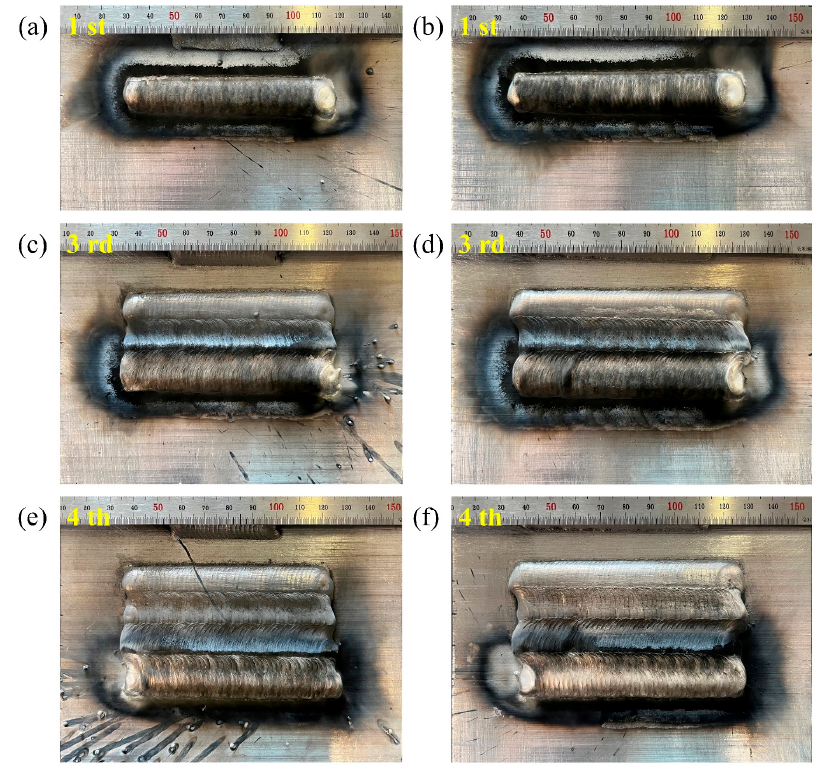
Figure 14. Appearance comparison: ( a , c , e ) 1, 3 and 4 deposited passes obtained before optimization, respectively; ( b , d , f ) 1, 3 and 4 deposited passes obtained after optimization, respectively.